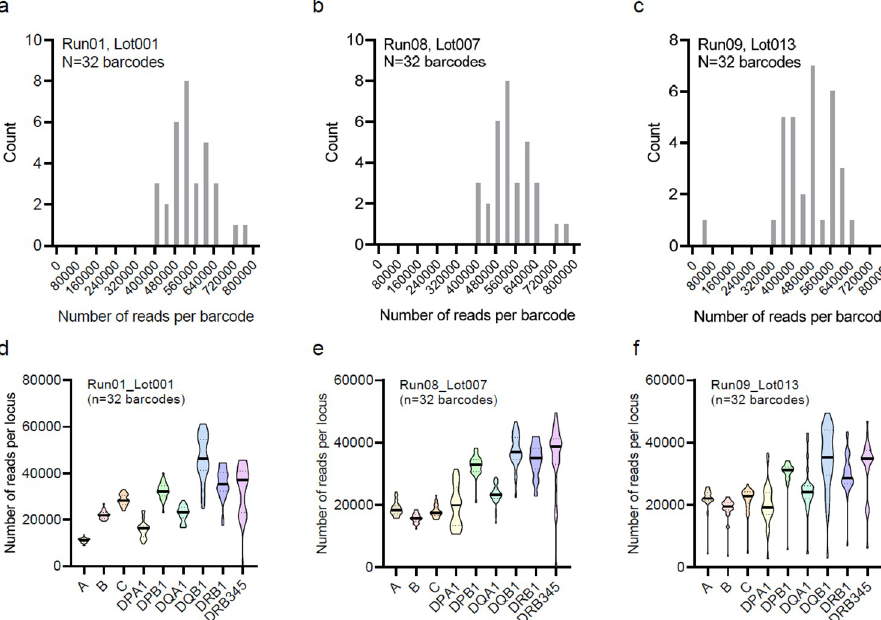
Fig 5. Distribution of the number of reads per sample and per locus. The histogram of read count per sample was plotted for three independent runs performed with three different lots of AllType reagents: a) Run01, Lot001. b) Run08, Lot007. c) Run09, Lot013. The number of reads per locus was also summarized for these runs: d) Run01, Lot001. e) Run08, Lot007. f) Run09, Lot013. Each run included 32 barcoded samples. Median (solid line) and interquartile (dotted line) are shown in the violin plots (d-f).